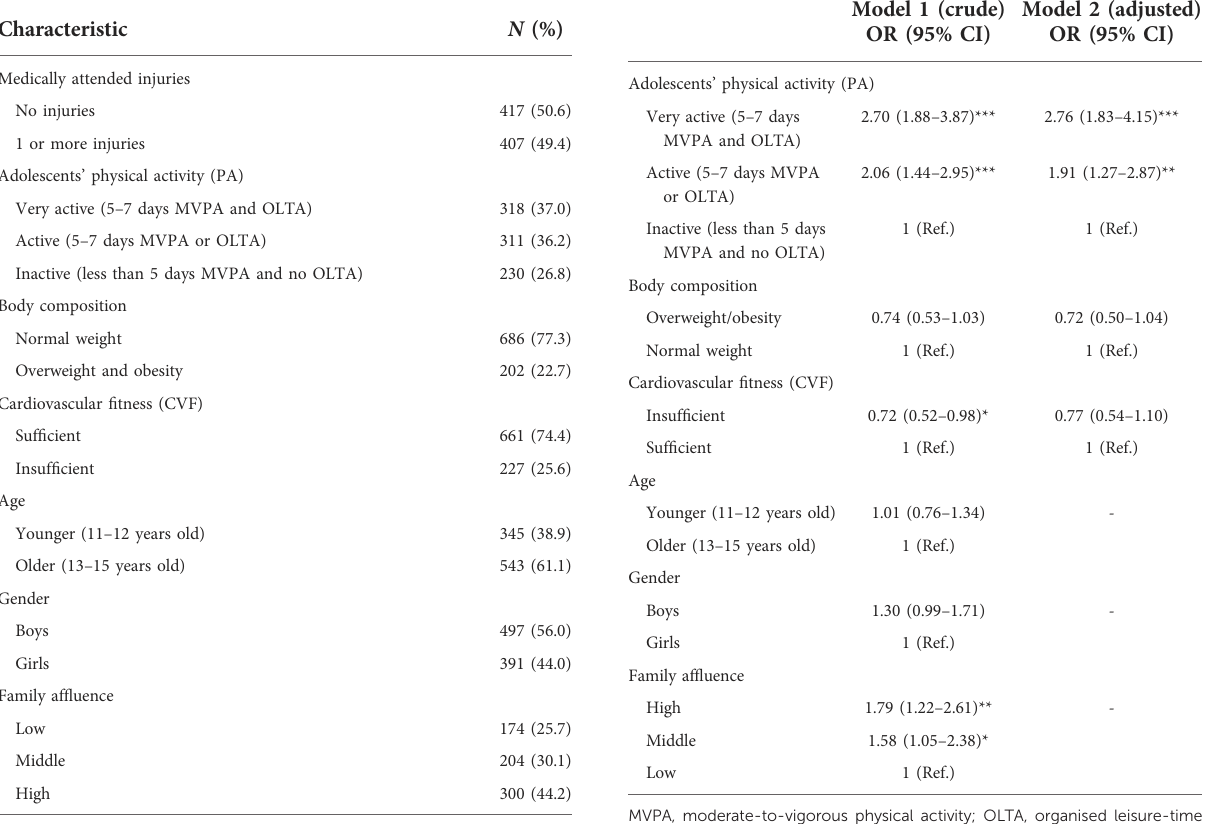
TABLE 2 Association of medically attended injuries with adolescents ’ physical activity, body composition, cardiovascular fi tness, and socio-demographic factors: odds ratios (OR) and 95% con fi dence intervals (95%-CI), resulting from binary logistic regression models, crude and adjusted for age, gender and family af fl